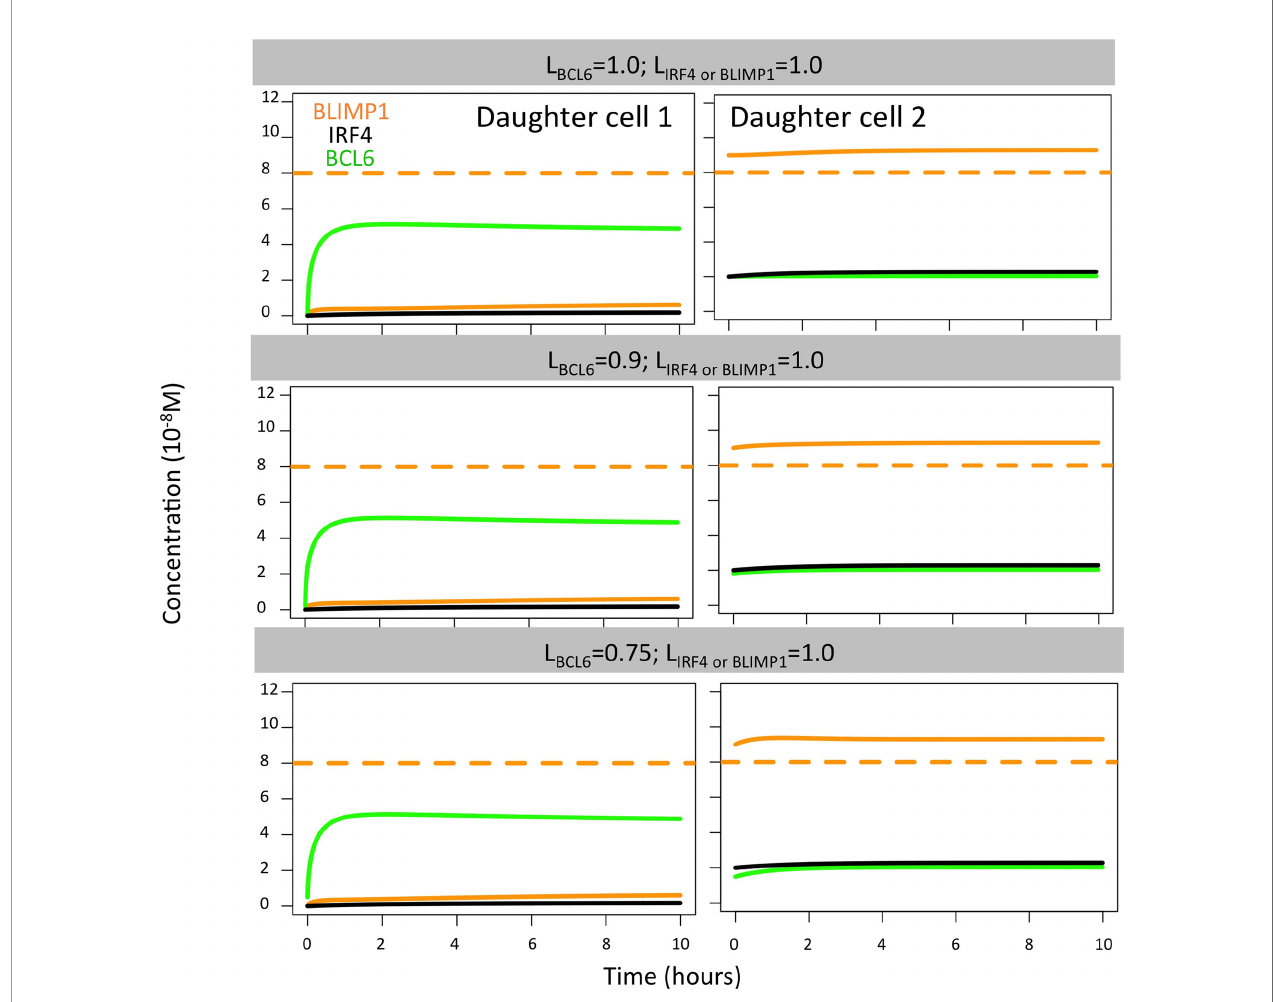
FIGURE 8 | BLIMP1 (orange), BCL6 (green), and IRF4 (black) dynamics in two theoretical daughter B cells. Their initial TF concentrations were set to simulate the asymmetric division of a parent cell (BLIMP1 = 8, BCL6 = 2, IRF4 = 2) with all different combinations of BCL6 levels (L BCL6 = 1.0, L BCL6 = 0.9, and L BCL6 = 0.75, as shown in Table 2 ). Levels of IRF4 and BLIMP1 were fi xed (L IRF4 = L BLIMP1 =